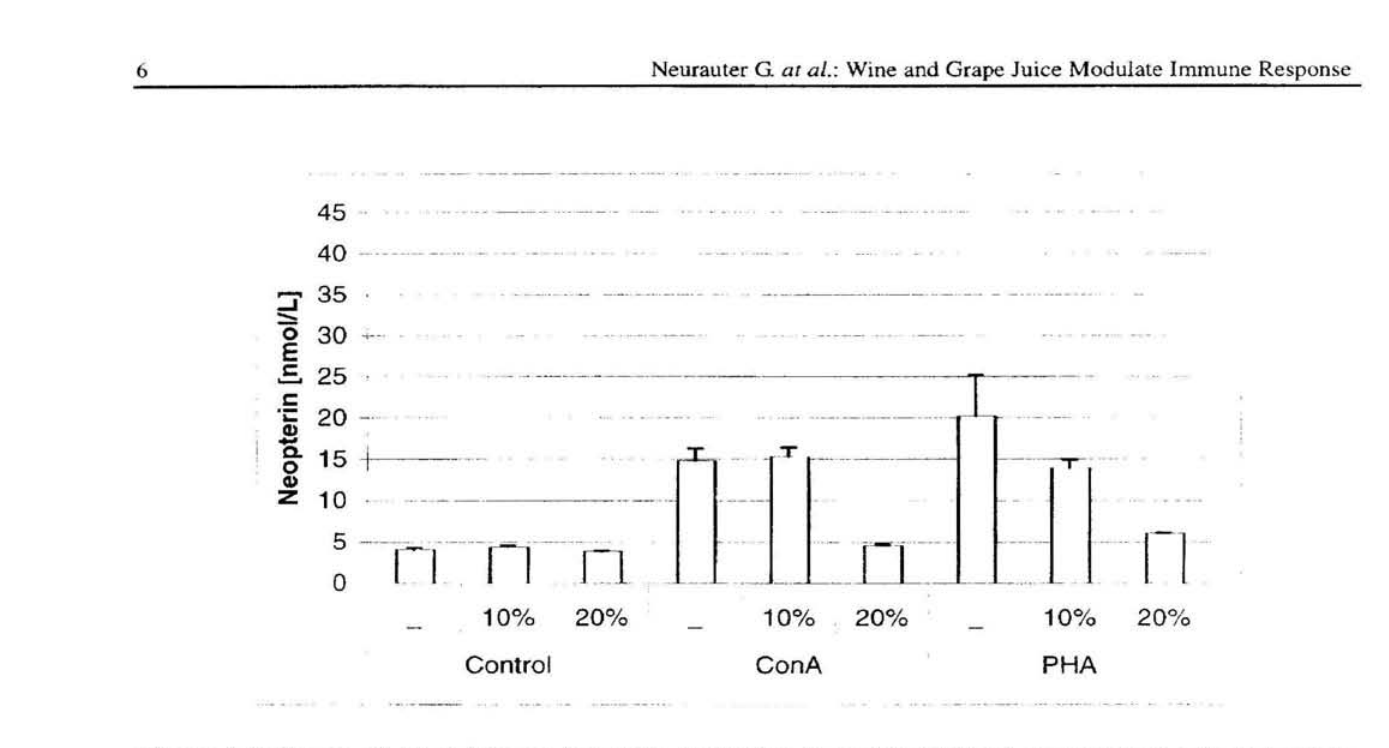
Figure 4. Influence of grape juice on neopterin production in peripheral blood mononuclear cells induced by mitogens concanavalin A (Con A) and phytohaemagglutinin (PHA); 1:10 (= 10% v/v) and 1:5 (= 20% v/v) dilu- tions of grape juice in RPMI were tested (columns show means + S.E.M.; #p <0.01) with IFN -y